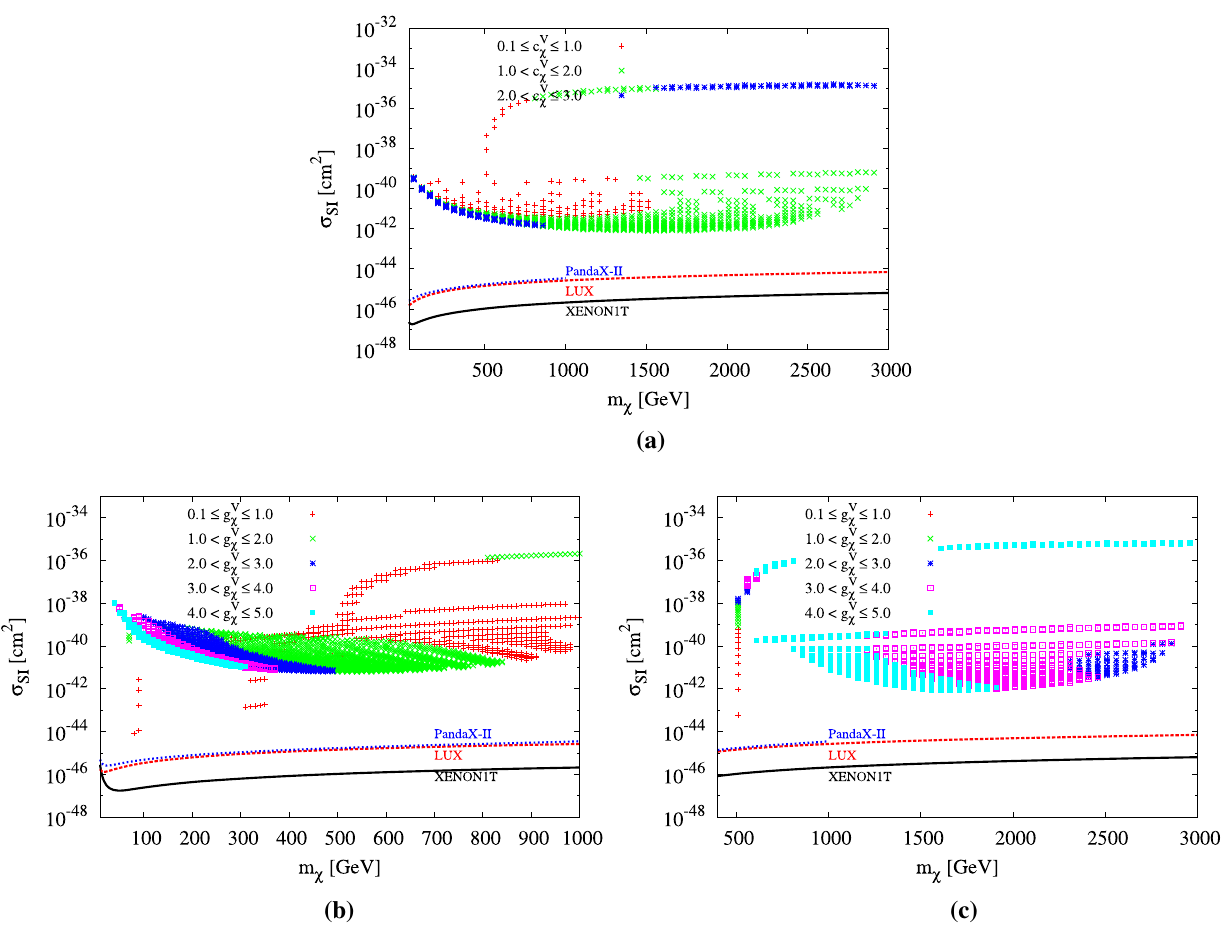
Fig. 2 The spin-independent proton-DM cross-section σ SI . The top and the bottom panels correspond to dimension-4 and dimension-5 vec- tor interactions. The left and the right bottom panels correspond to the cut-off scales 1 TeV and 5 TeV respectively. The colour gradient stands for different Yukawa couplings. All parameters are consistent with the